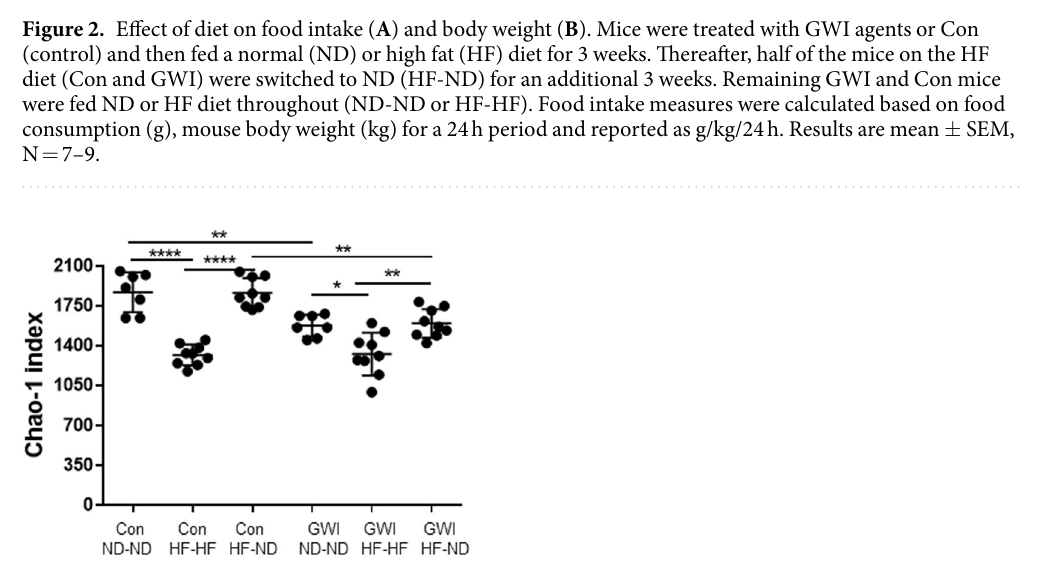
Figure 3. Effects of GWI ± HF on α -diversity. Data are presented as Chao-1 ± SEM, N = 8-9. Con = control; GWI = PER + PB; ND = normal diet; HF = high fat diet. Symbols represent significance levels for the indicated post hoc comparisons as p < * 0.05, ** 0.01, ****